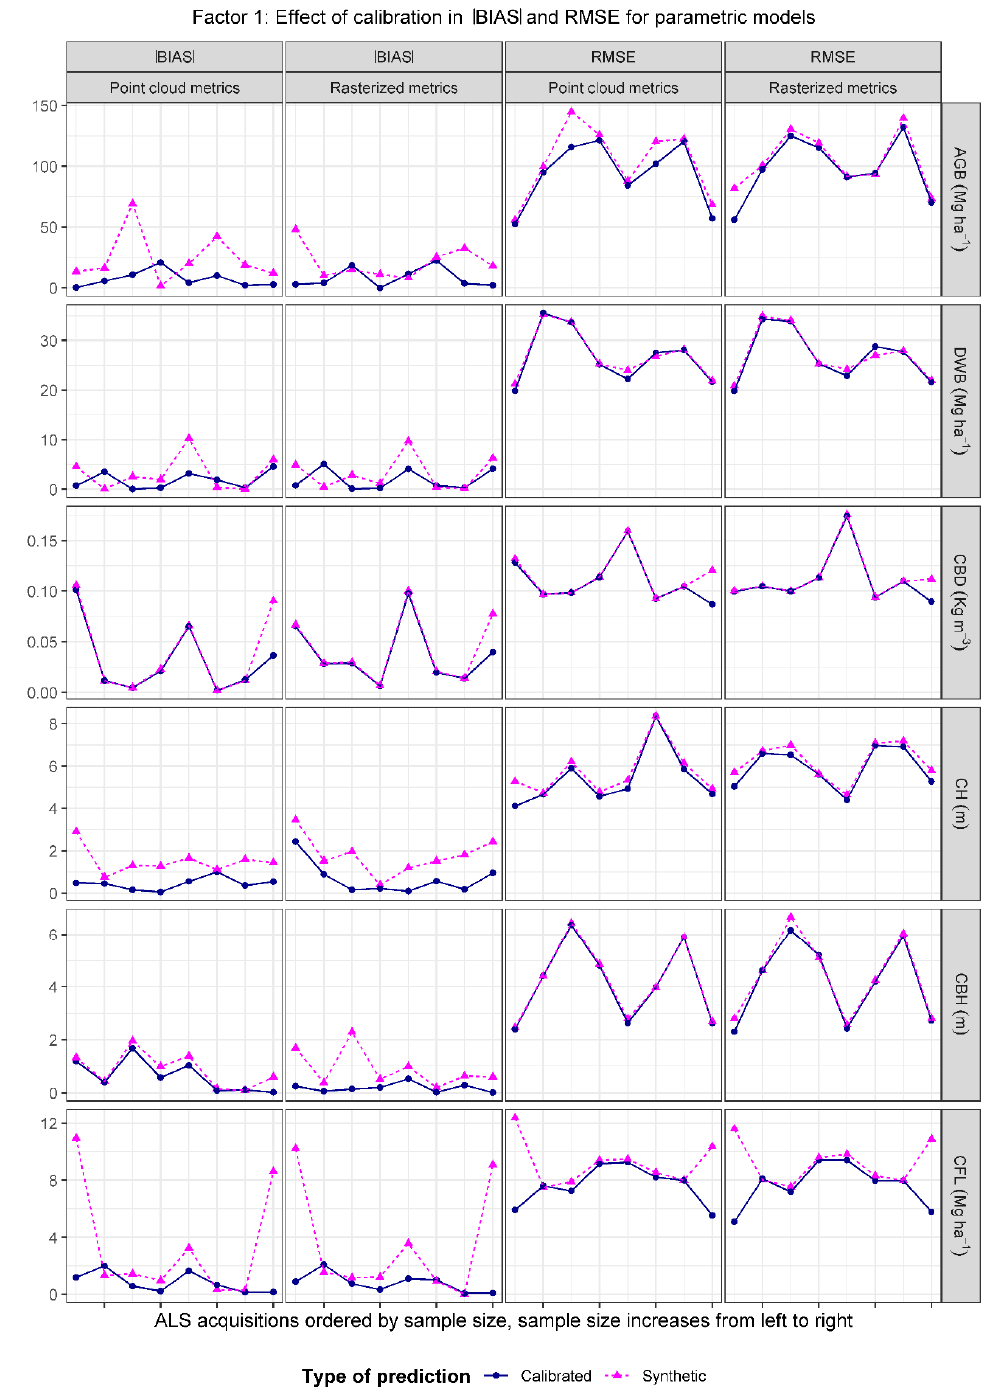
Figure 5. Absolute value of bias, | BIAS | , and root mean square error, RMSE , for synthetic and calibrated predictions of parametric models by ALS data acquisitions. AGB, DWB, CBD, CH, CBH, and CFL respectively indicate aboveground biomass, downed woody biomass, canopy bulk density, canopy height, canopy base height, and canopy fuel load.